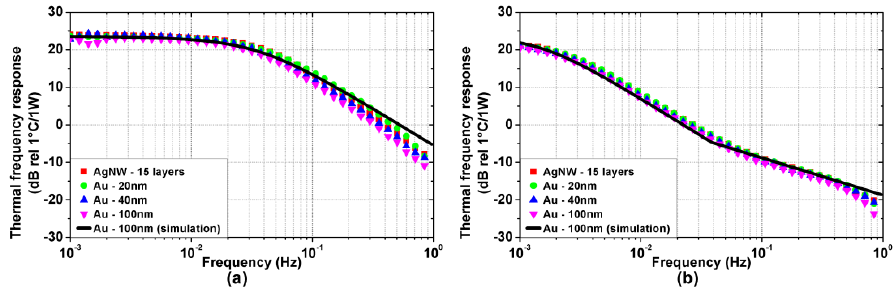
Figure 4. Experimental (colored symbols) and simulated (black solid line) thermal frequency responses (power to temperature) of the TA loudspeaker samples on ( a ) Kapton and ( b ) glass